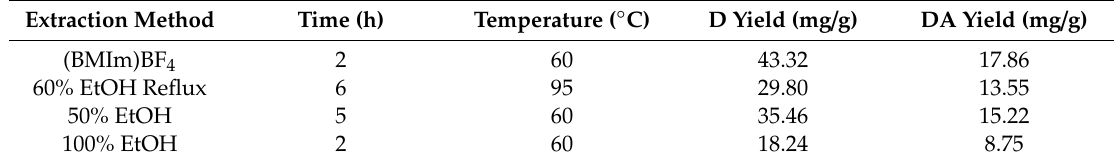
Table 4. Comparison of the (BMIm)BF 4 extraction method with conventional extraction